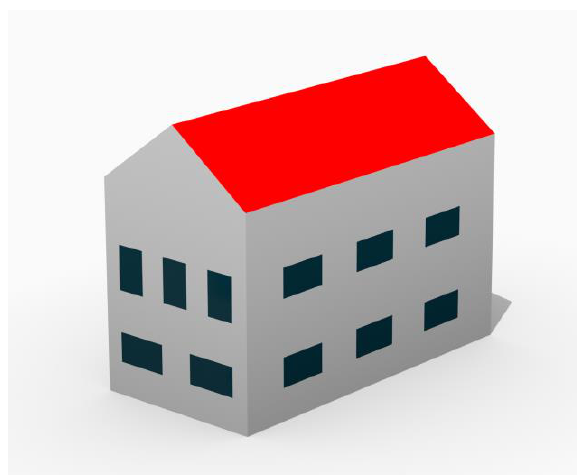
Figure 4. A coarse representation of the exterior of a building with